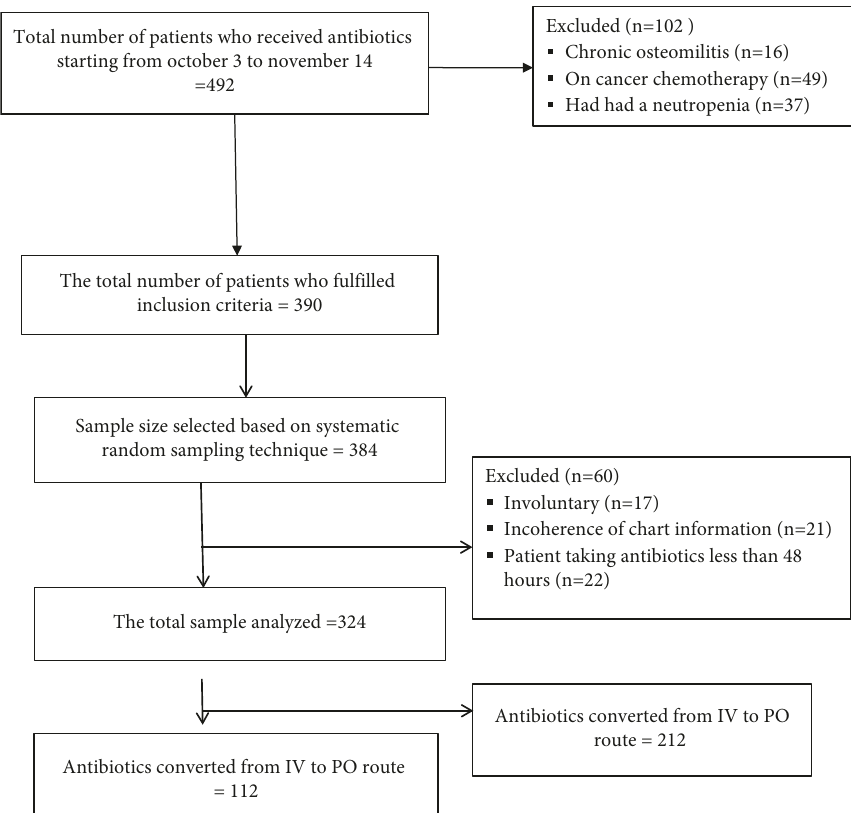
Figure 1: The procedure of sample size calculation on IV to PO conversion practice of antibiotics at the University of Gondar Specialized Hospital from October 3 to November 14, 2021 ( n �